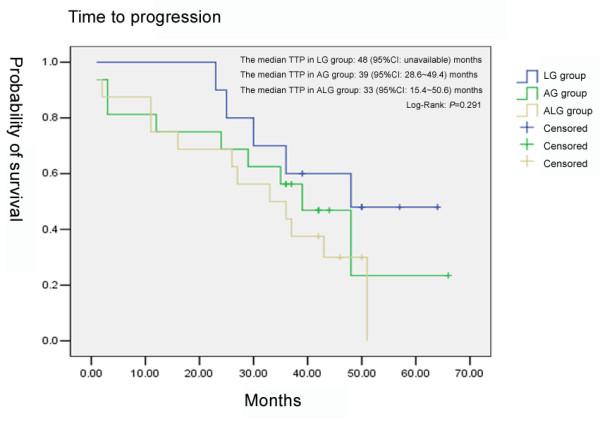
Comparison of the time to progression among the three groups.